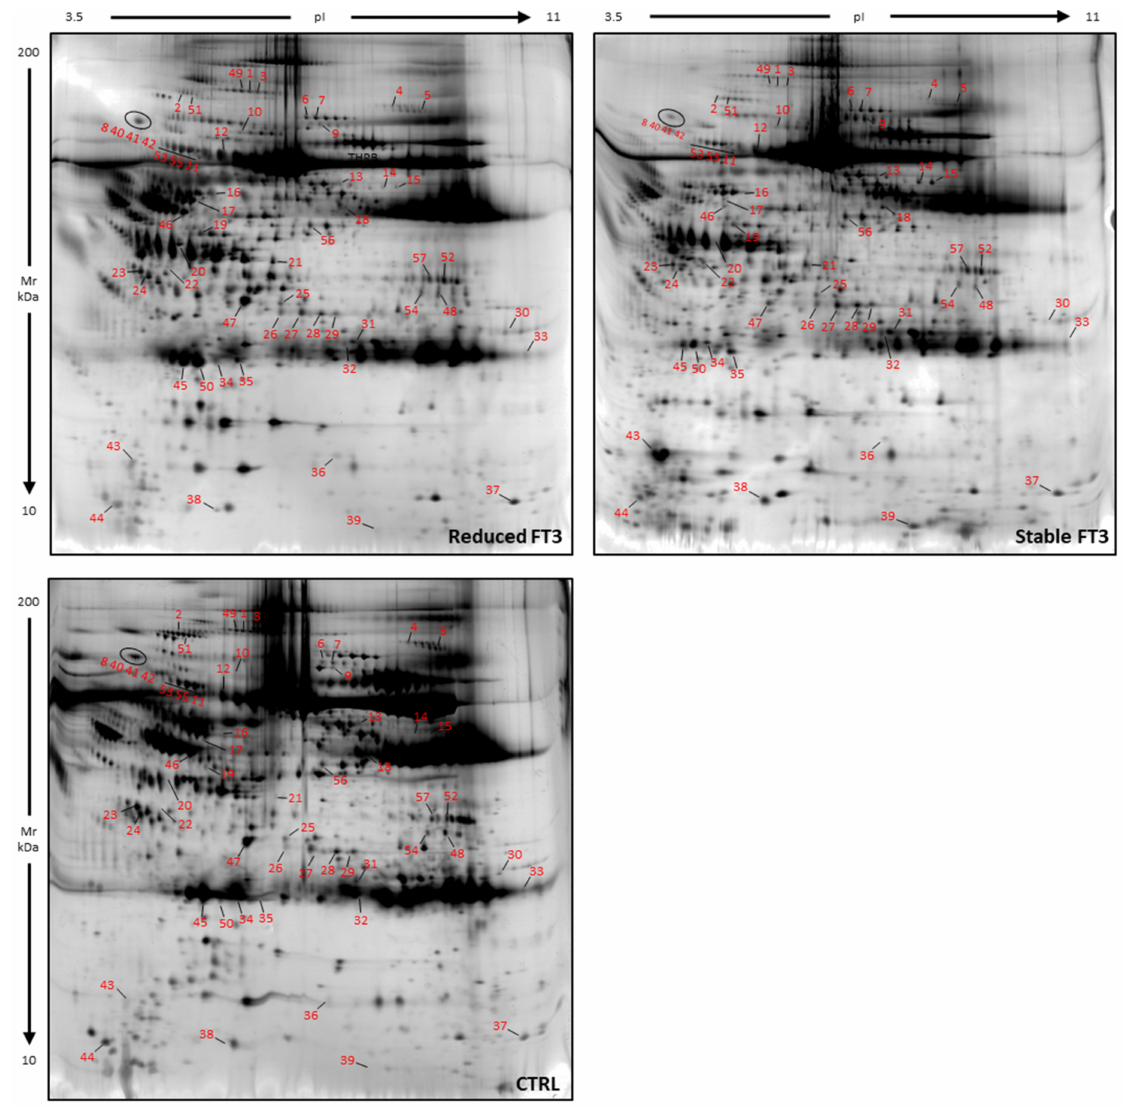
Figure 1. Electrophoretic maps of reduced FT3, stable FT3 samples, and control (CTRL), highlighting the differential spots found. Numbers in red correspond to that in Table